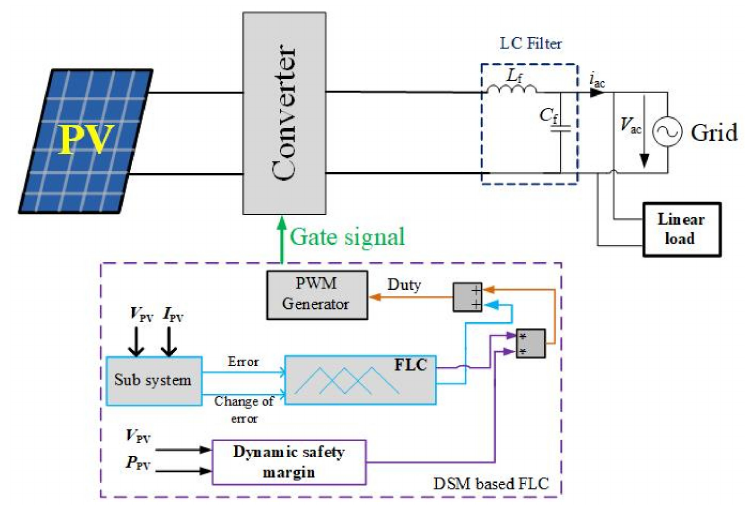
Figure 7. General configuration of MPPT using DSM based FLC.